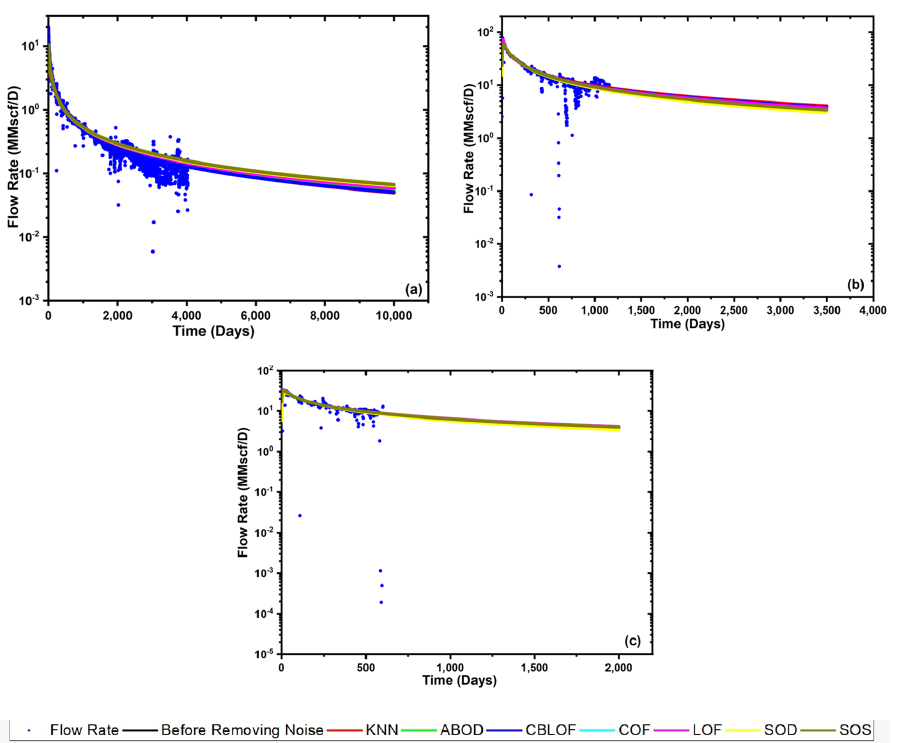
Figure 20. Applying Duong decline model before and after removing noise using the seven OD algorithms for; ( a ) Well_12, ( b ) Well_29, and ( c ) Well_40.